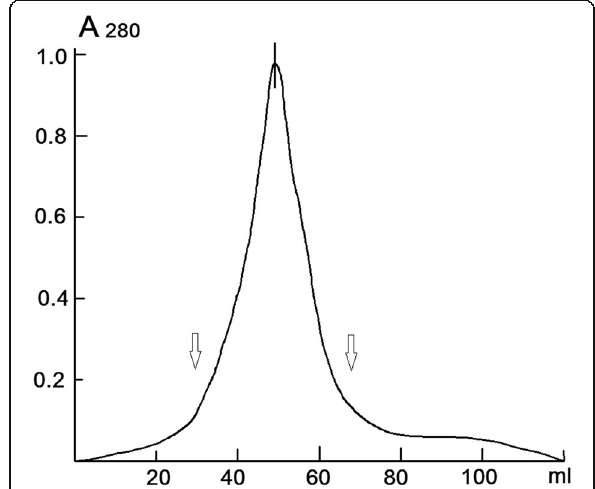
Fig. 1 Chromatographic elution graph of suprol after loading on a column with Biogel P-150 at pH 9.5. For further research, the central fraction was used (indicated by arrows) ( p < 0.05, n = 6)